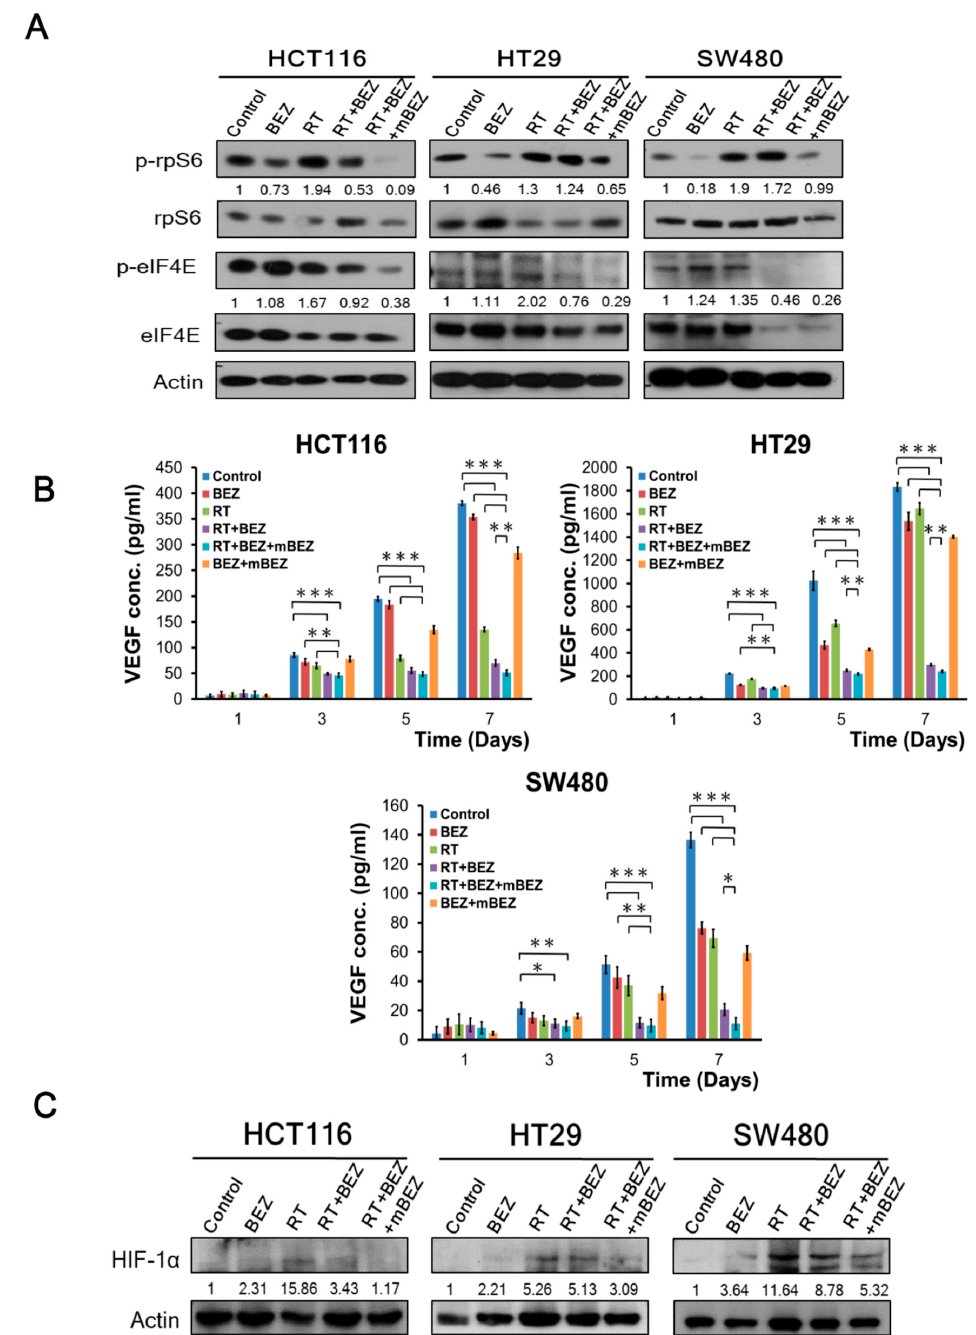
Figure 3. BEZ235 maintenance treatment following RT + BEZ235 treatment sensitized CRC cells to radiation by attenuating mTOR signaling- and angiogenesis-associated molecules. ( A ) BEZ235 maintenance treatment caused a marked decrease in radiation-induced phosphorylation levels of rpS6 and eIF4E in the CRC cells. The relative amounts of phosphorylated and non-phosphorylated proteins were quantified. The relative ratio of the control group was defined as 1. ( B ) VEGF-A concentrations were analyzed via enzyme-linked immunosorbent assay (ELISA). The results are expressed as the mean ± standard error (SE) of three experiments. * p < 0.05; ** p < 0.01; *** p < 0.001. ( C ) BEZ235 maintenance treatment significantly inhibited HIF-1 α expression when compared with RT and RT + BEZ235 treatment in three CRC cells. The relative amounts of phosphorylated and non-phosphorylated proteins were quantified. The relative ratio of the control group was defined as